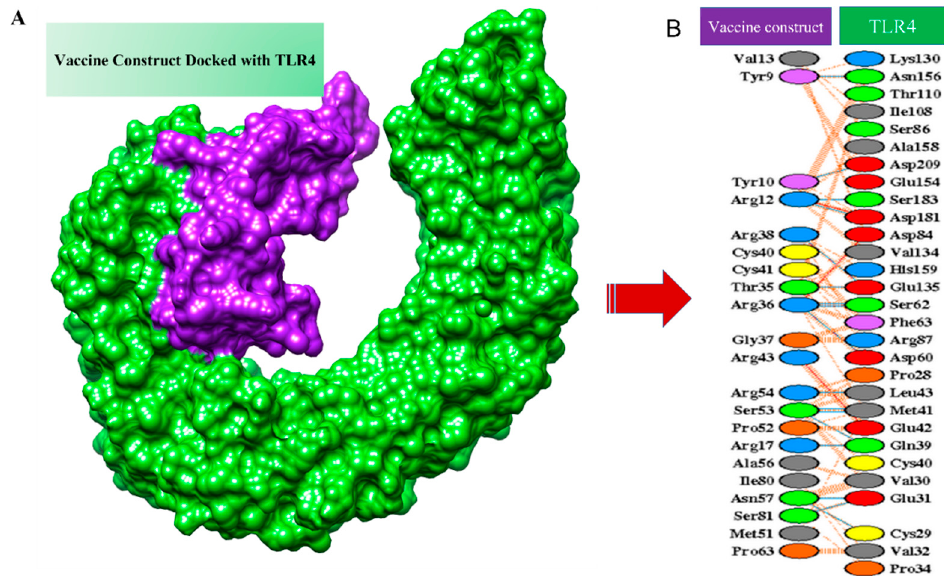
Figure 7. Docked complex. ( A ) Docked complex of designed vaccine with TLR4. ( B ) Protein–protein interaction of the vaccine and the receptor, which is TLR4. Table 4. Top models of docked complexes of designed vaccine with TLR4 .